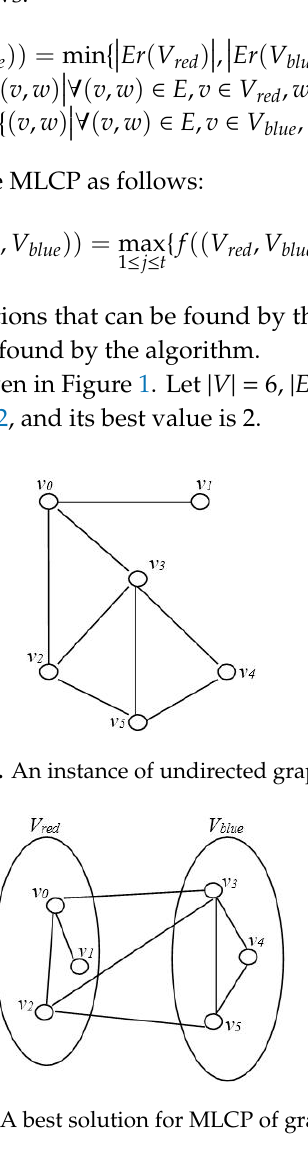
Figure 2. A best solution for MLCP of graph G .